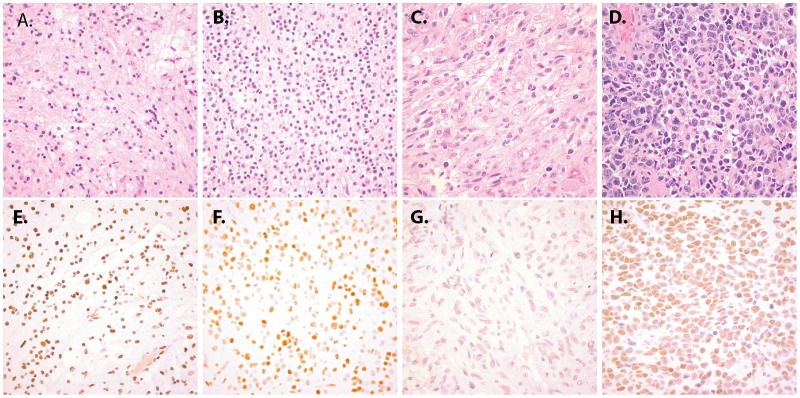
Representative 5hmC staining in glioma.Human brain tumor tissue sections were stained with hematoxylin and eosin (A–D) or with antibodies specific for 5hmC (E–H). Relatively high levels of 5hmC staining was seen in pilocytic astroycytomas (E) and oligodendrogliomas (F). In contrast, glioblastomas overall had reduced 5hmC levels (G). A rare glioblastoma showing relatively high levels of 5hmC staining is shown in panel (H). Original magnification for all photomicrographs is 200x.